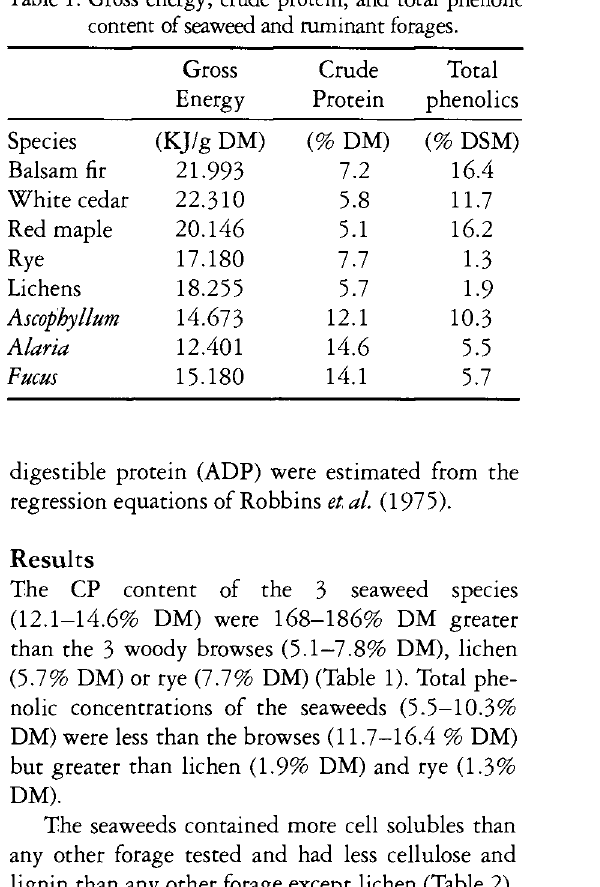
Table 1. Gross energy, crude protein, and total phenolic content of seaweed and ruminant forages.